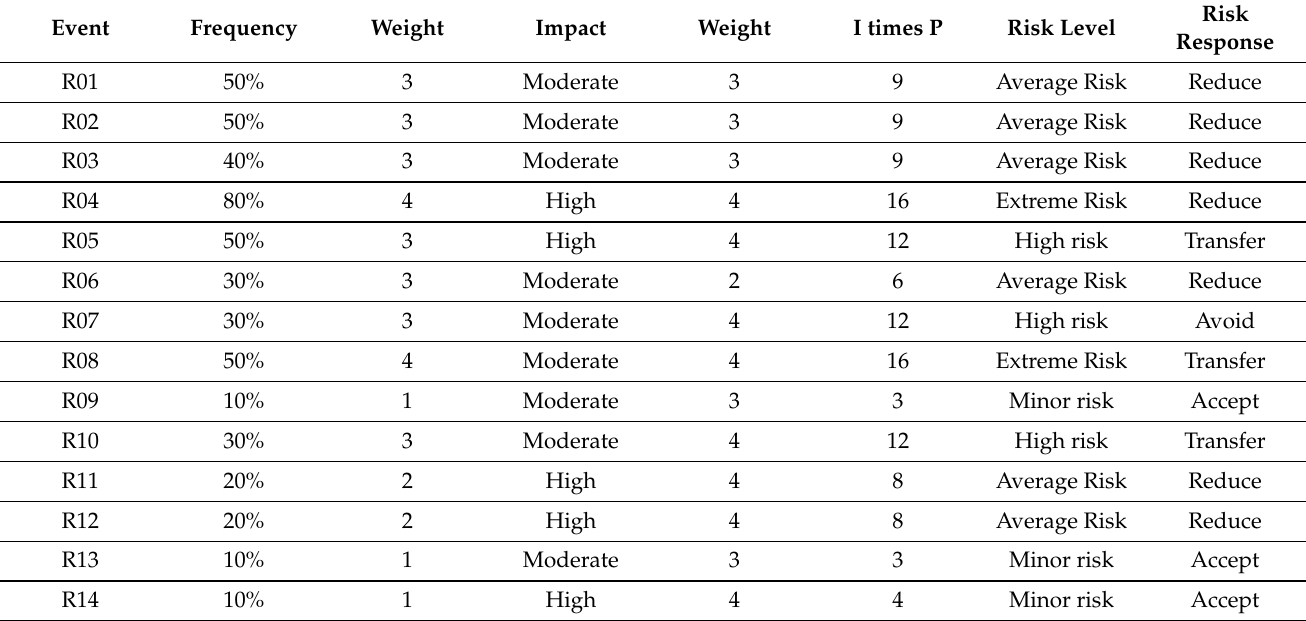
Table 6. Risk Assessment of the Manage Information System process.